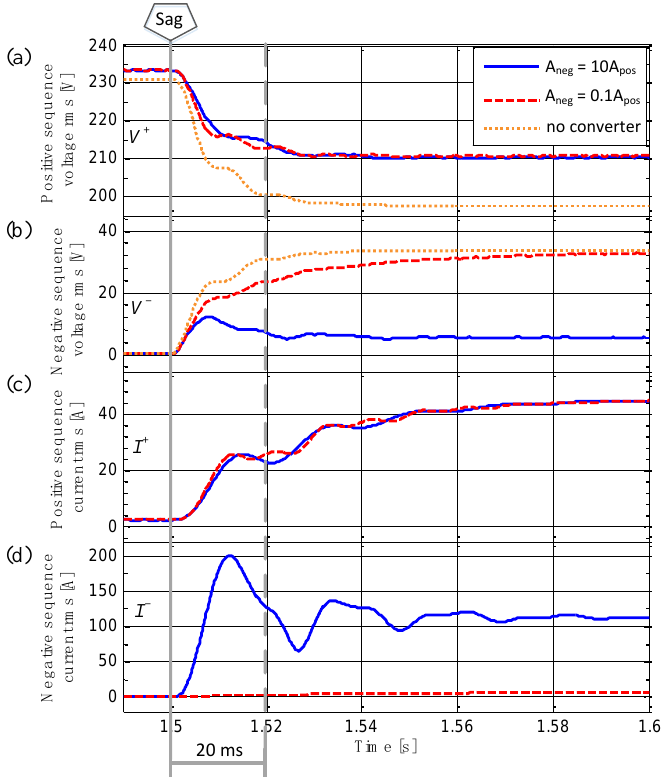
Figure 8. Comparison of the unbalanced voltage support effect of the SPC-based power converter under different negative-sequence virtual admittances: ( a ) positive sequence PCC voltage rms; ( b ) negative sequence PCC voltage rms; ( c ) positive sequence current rms; and ( d ) negative sequence current rms.